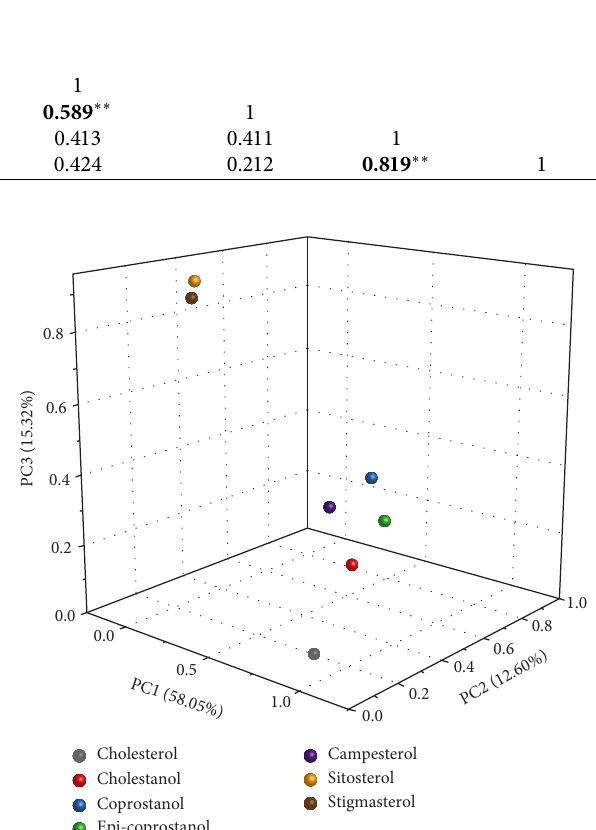
Figure 5: Principal component analysis of sterols in sediments of the Guanting Reservoir.